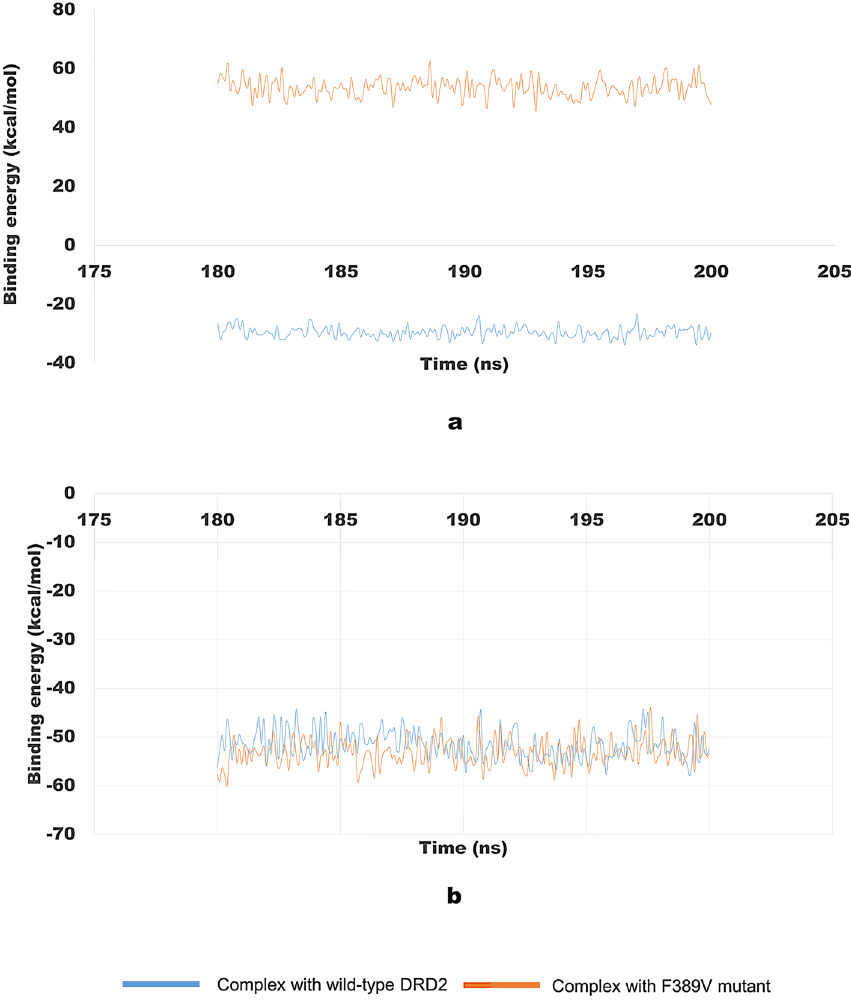
Figure 8. Binding free energy of the docked complexes during the last 20 ns of Molecular Dynamics Simulation by GROMACS software. ( a ) Complex of dopamine with native DRD2 (blue) and F389 V mutant (orange), ( b ) Complex of risperidone with native DRD2 (blue) and F389 V mutant (orange).